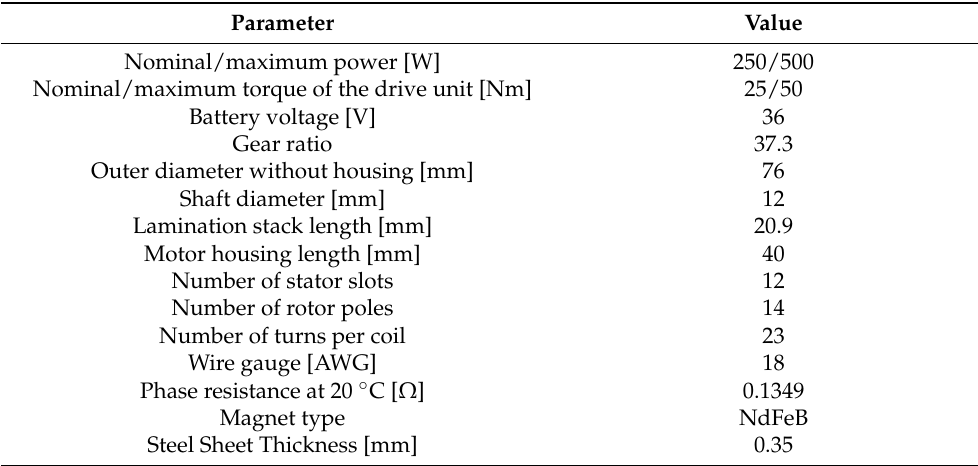
Table 2. Main parameters of the Shimano Steps drive unit.